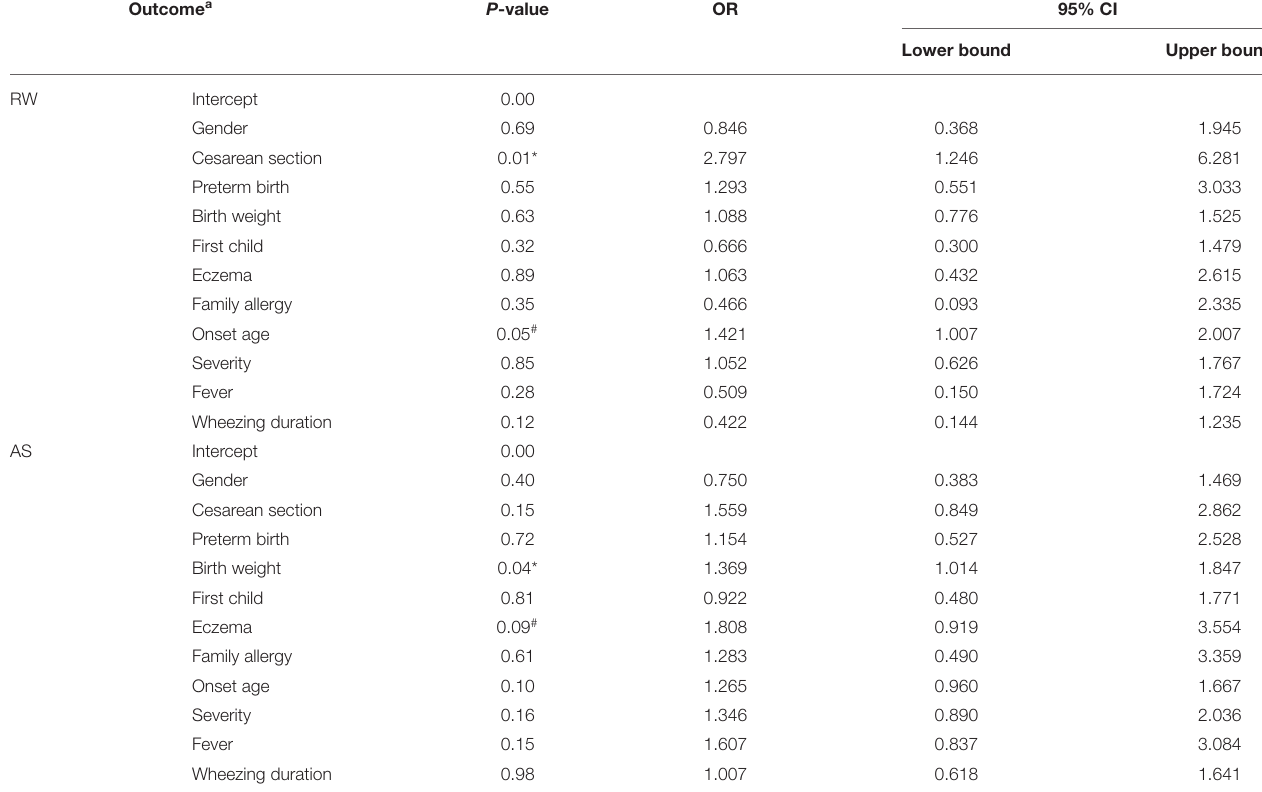
Lower bound Upper bound